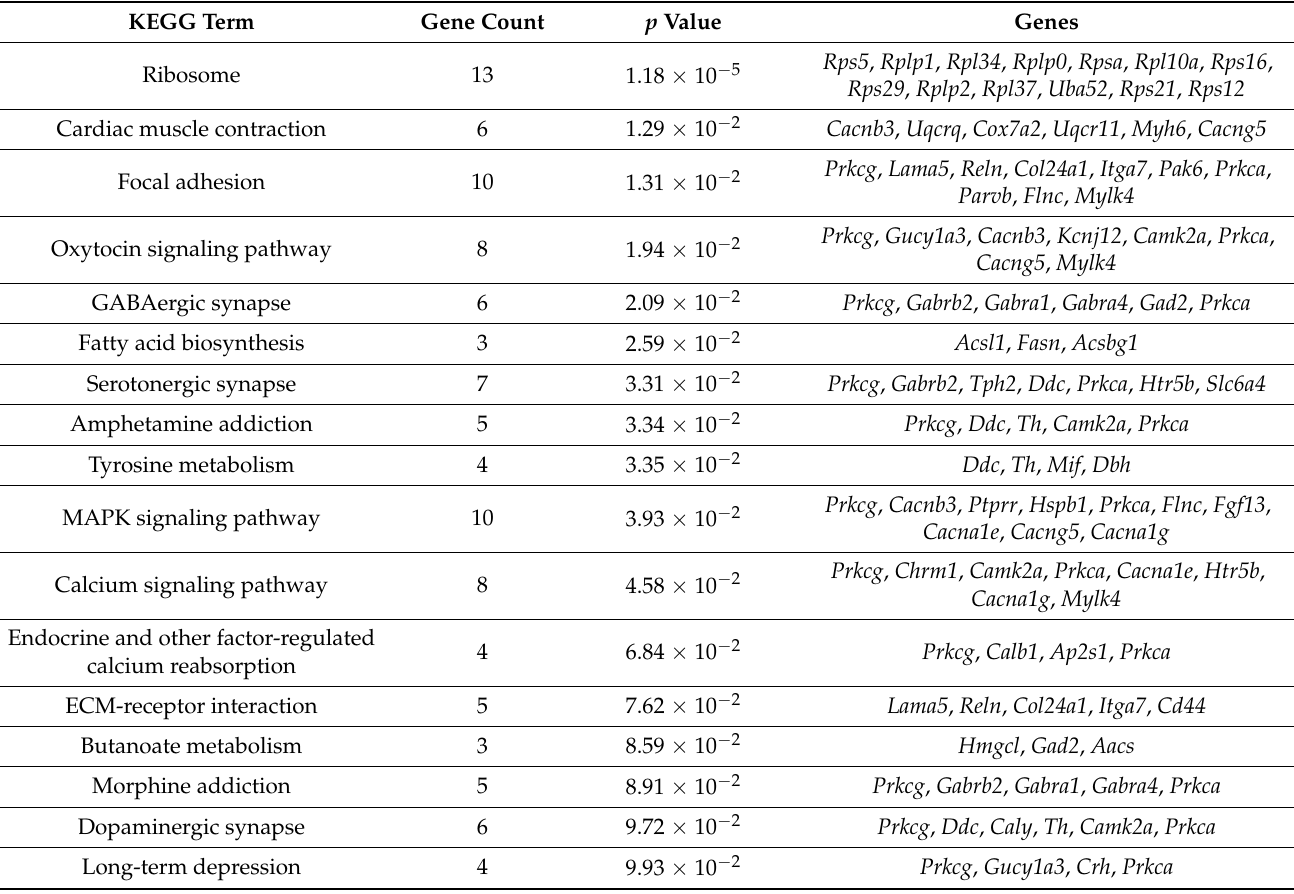
Table 1. KEGG terms most significantly related to the DEGs in the MRNs of the winning mice compared to controls. KEGG Term Gene Count p Value Genes